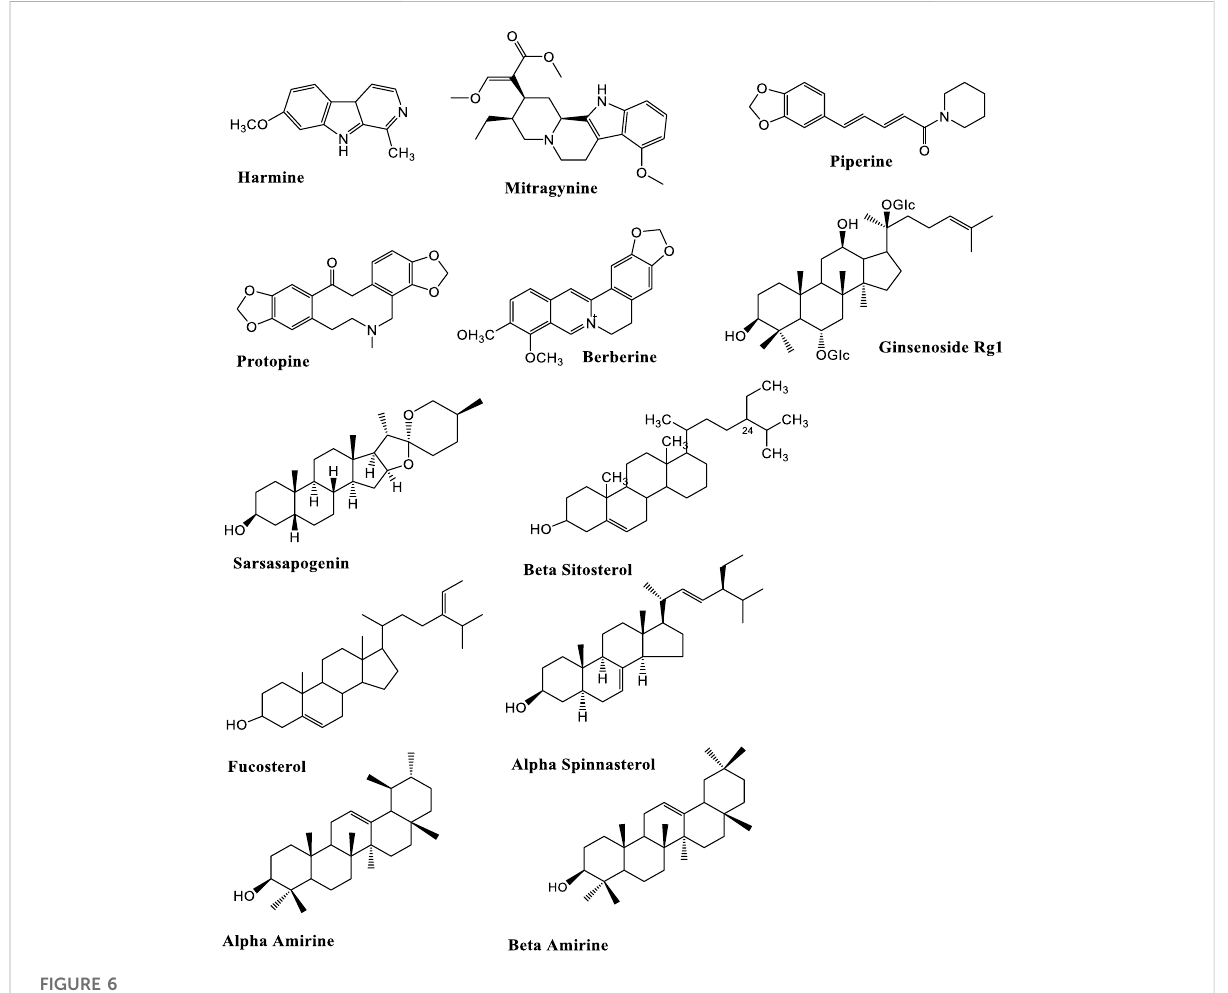
Chemical structures of potential anti-depressant alkaloids, saponins and